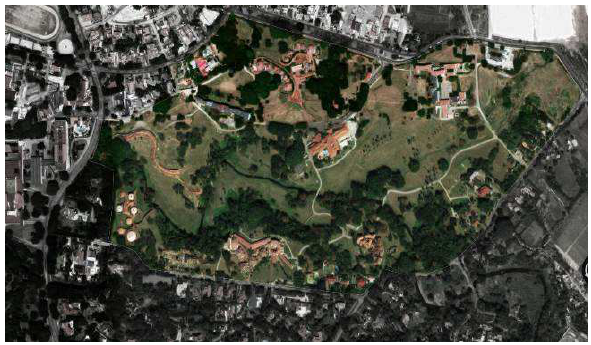
Figure 1. National Art Schools, Havana (elaboration of Google Maps image)